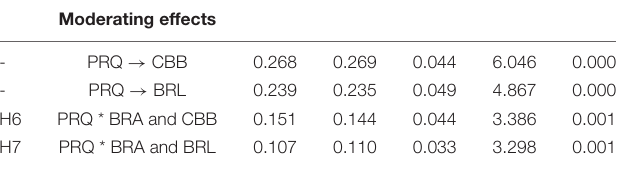
TABLE 8 | Moderation